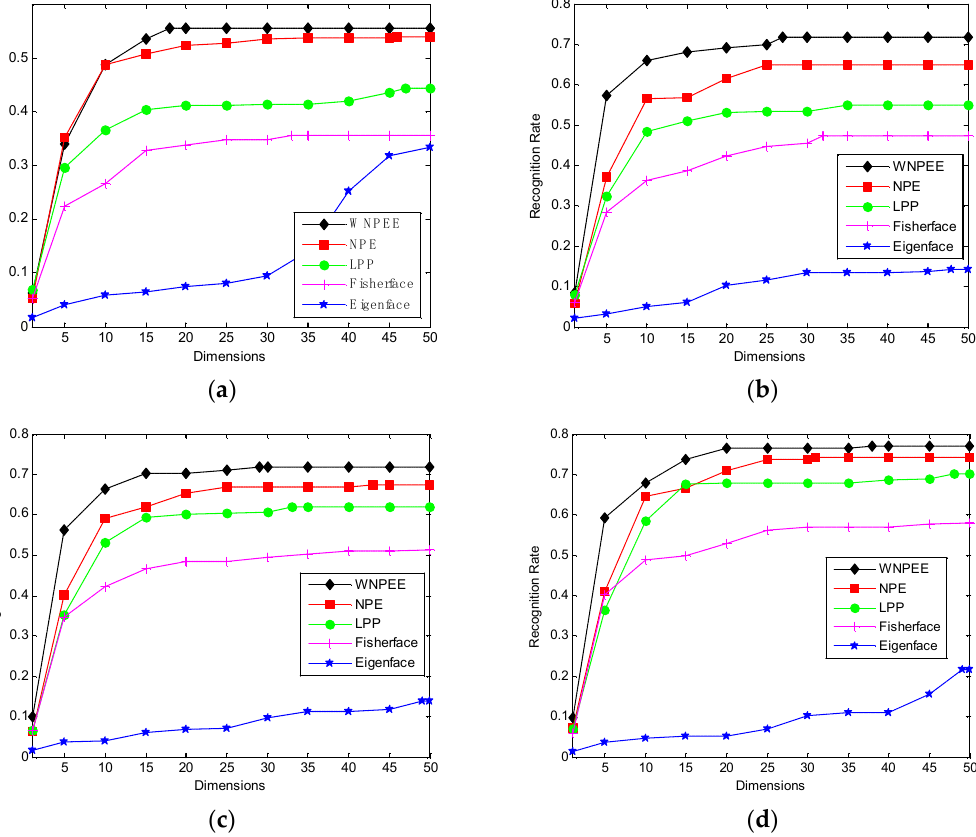
Figure 4. Average recognition rate versus reduce dimensions on GT dataset. ( a ) l = 3, ( b ) l = 5, ( c ) l = 7,